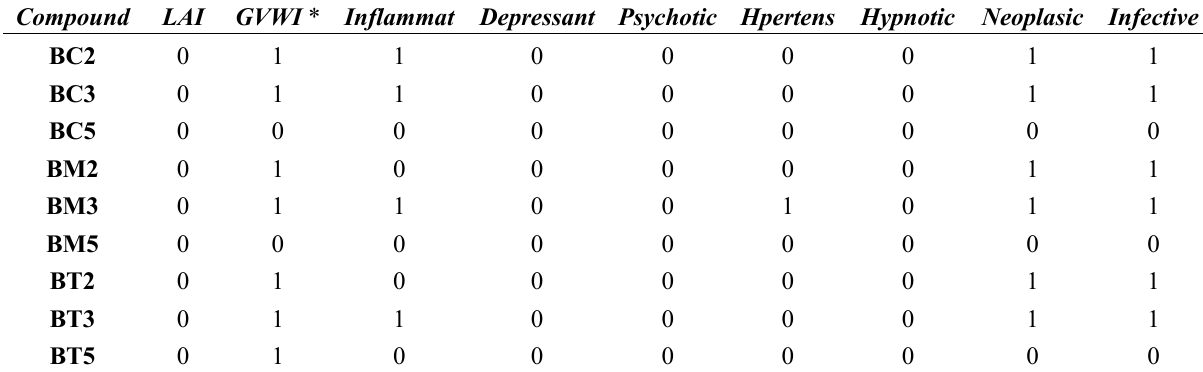
Table 2. Assessment of drug-like indices for the selected